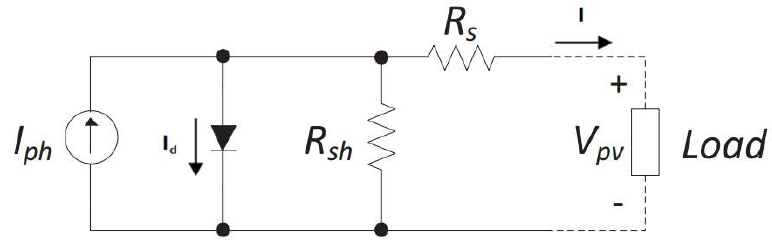
Figure 5. The equivalent circuit of a solar cell.